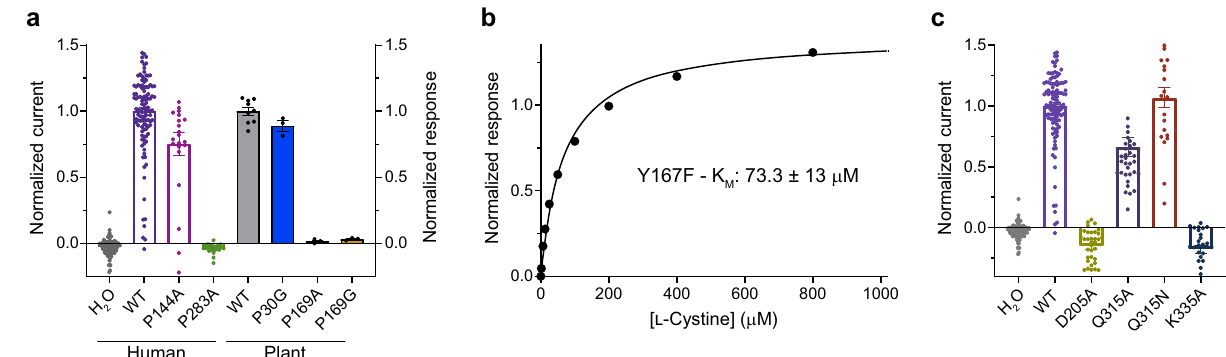
Fig.4 |RoleofPQmotifsincystinosin.a EffectofmutatingthePQ motifsinboth human and plant ( A. thaliana ) cystinosin. The human protein was assayed using TEVC ( n =109 independent experiments for H 2 O, n =113 for WT, n =22 for P144A and n =31 for P283A) whereas the plant transporter was analysed in reconstituted liposomes( n =9independentexperimentsforWTand n =3forvariants).Errorbars SEM. b Representative K M of plant cystinosinvariant Tyr167Phe.K M wascalculated